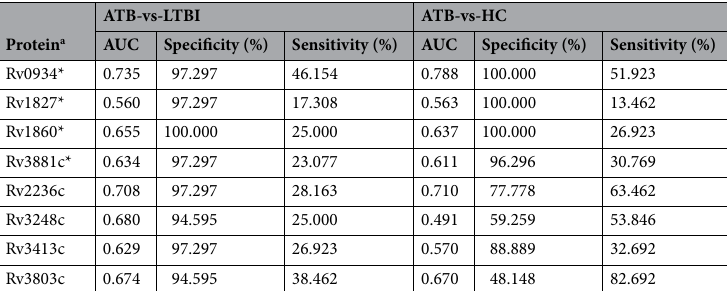
Table 2. AUC analysis of potential ATB diagnostic biomarkers in the ATB-vs-LTBI and ATB-vs-HC comparisons. a Proteins marked with an asterisk (*) were selected as candidate biomarkers in both